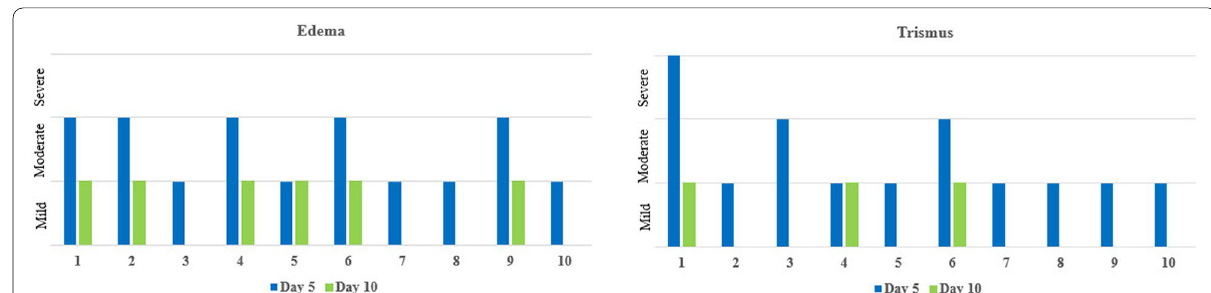
Abbreviations : B/A Mandibular body angel region & A Mandibular angel region